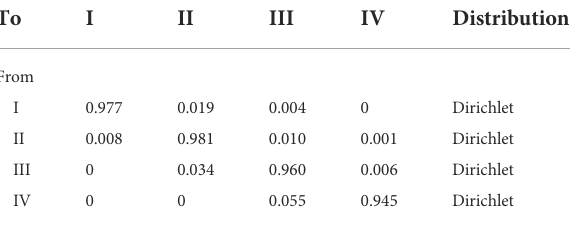
TABLE 2 New York Heart Association classes transition probabilities per cycle (3 months). To